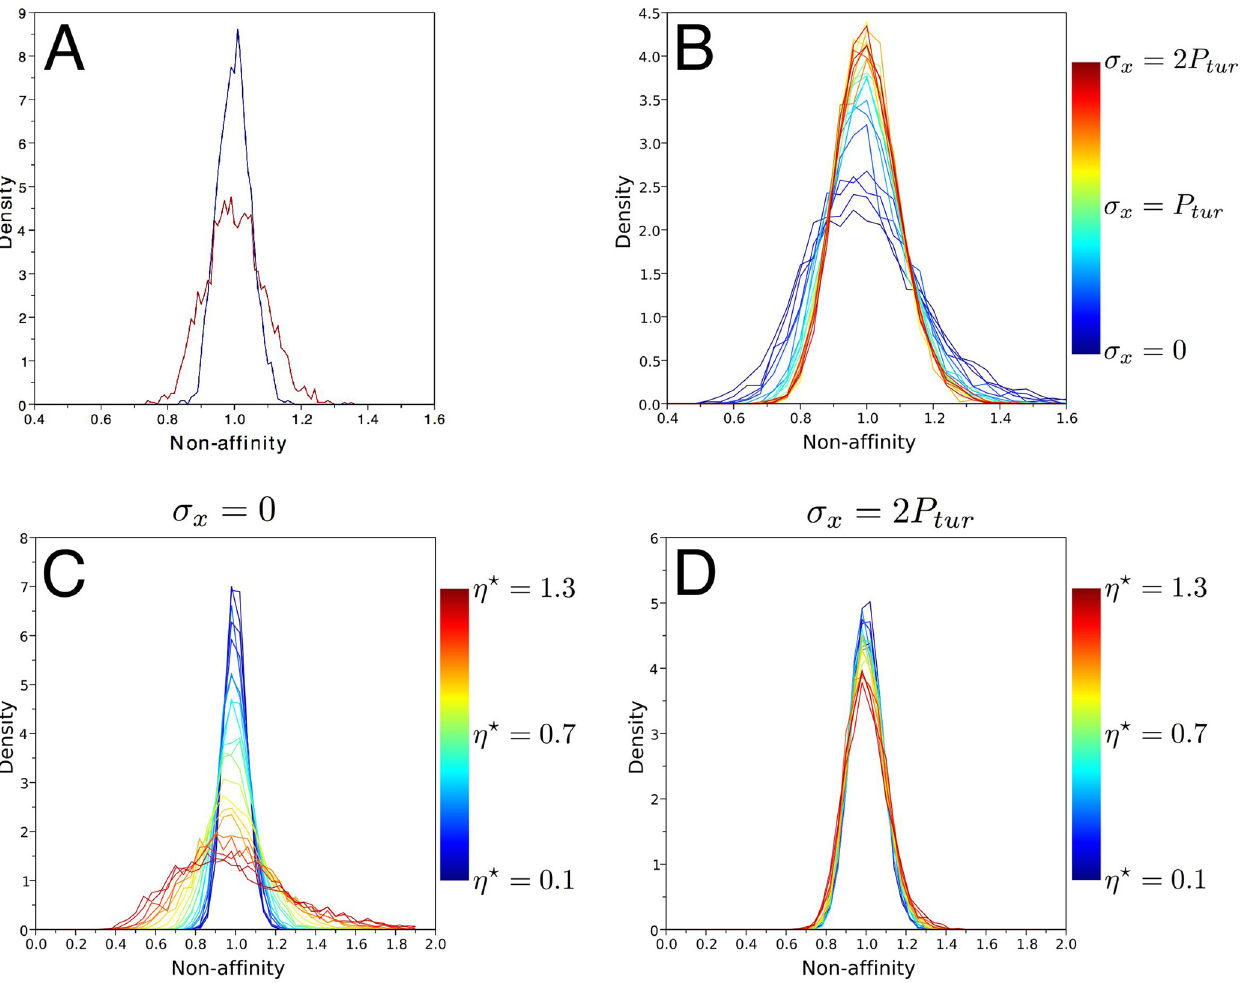
Fig 7. Model with randomness in vein thickness and threshold in the growth law. All panels show the stress-dependent distribution of non-affinity index q in all the simulations for a noise amplitude of r = 40%. (A) With no growth threshold ( η = 0) the distribution in the presence of anisotropic stress (red) is wider than without it (blue), in contrast to experimental finding (Fig 6C). (B) When a threshold, η = η 0 , is introduced, the trend is reversed, and the stressed tissue features a narrower distribution, in agreement with experiments. (C,D) Sensitivity of the results to the threshold; the normalized threshold η ? = η / η 0 ranges from 0.1 to 1.3. Panels (C) and (D) correspond, respectively, to σ x = 0 and σ x = 2 P tur